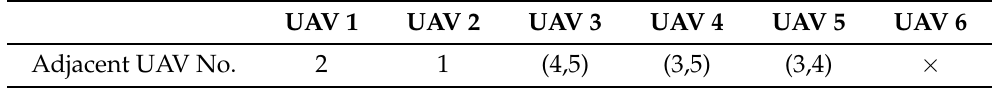
Figure 3. An illustrative example of three connected components of six UAVs. The construction results are given in Table 2. Table 1. Adjacent relationship among six UAVs. UAV 6 has no adjacent UAV.